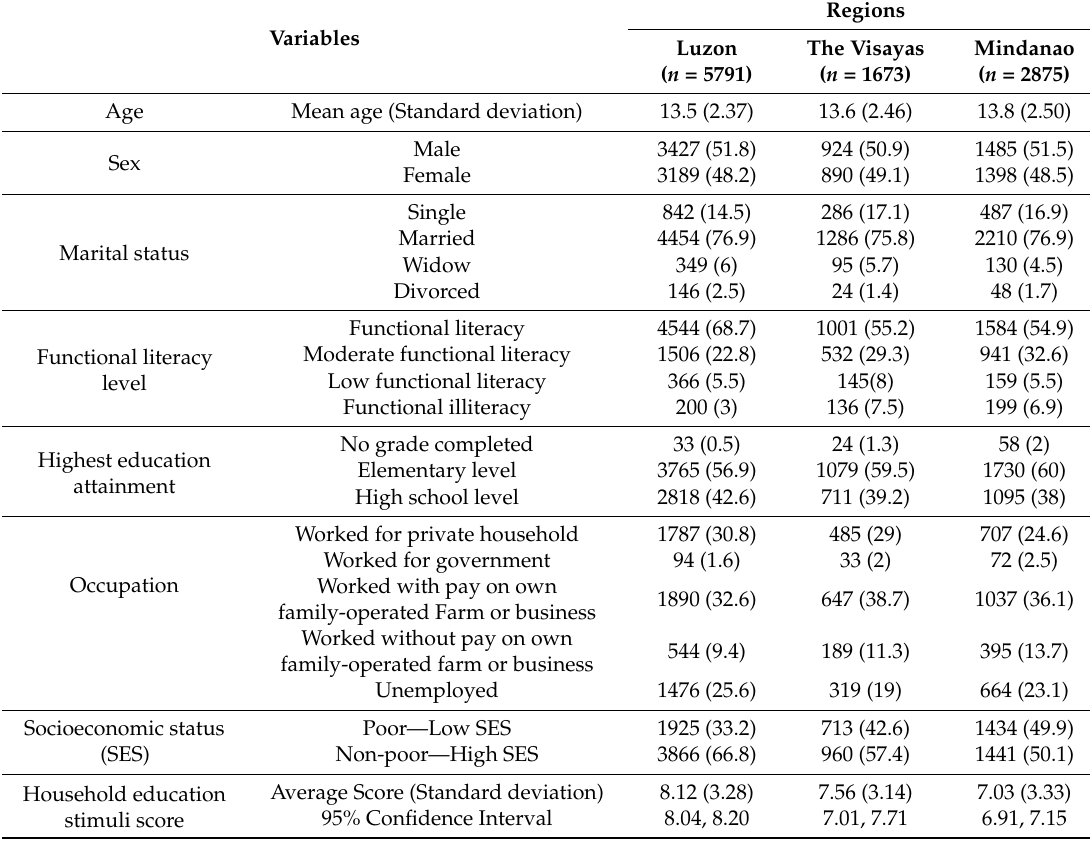
Table 2. Demographic characteristics of the heads of households and household socioeconomic status and education stimuli score, stratified by regions of the